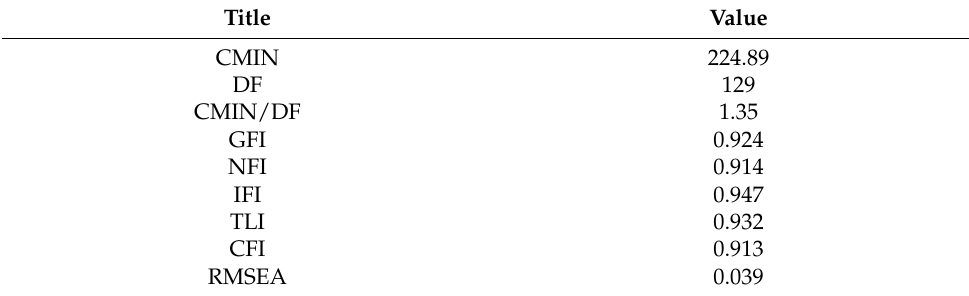
Table 6. Model fit results for competencies.